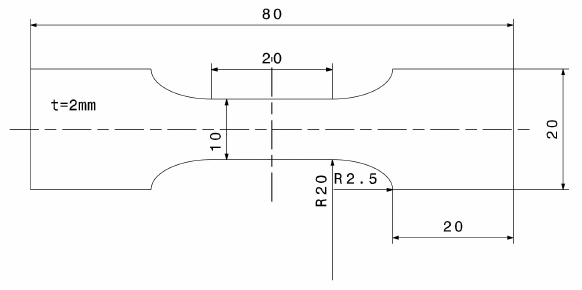
Figure 2. Specimen shape.